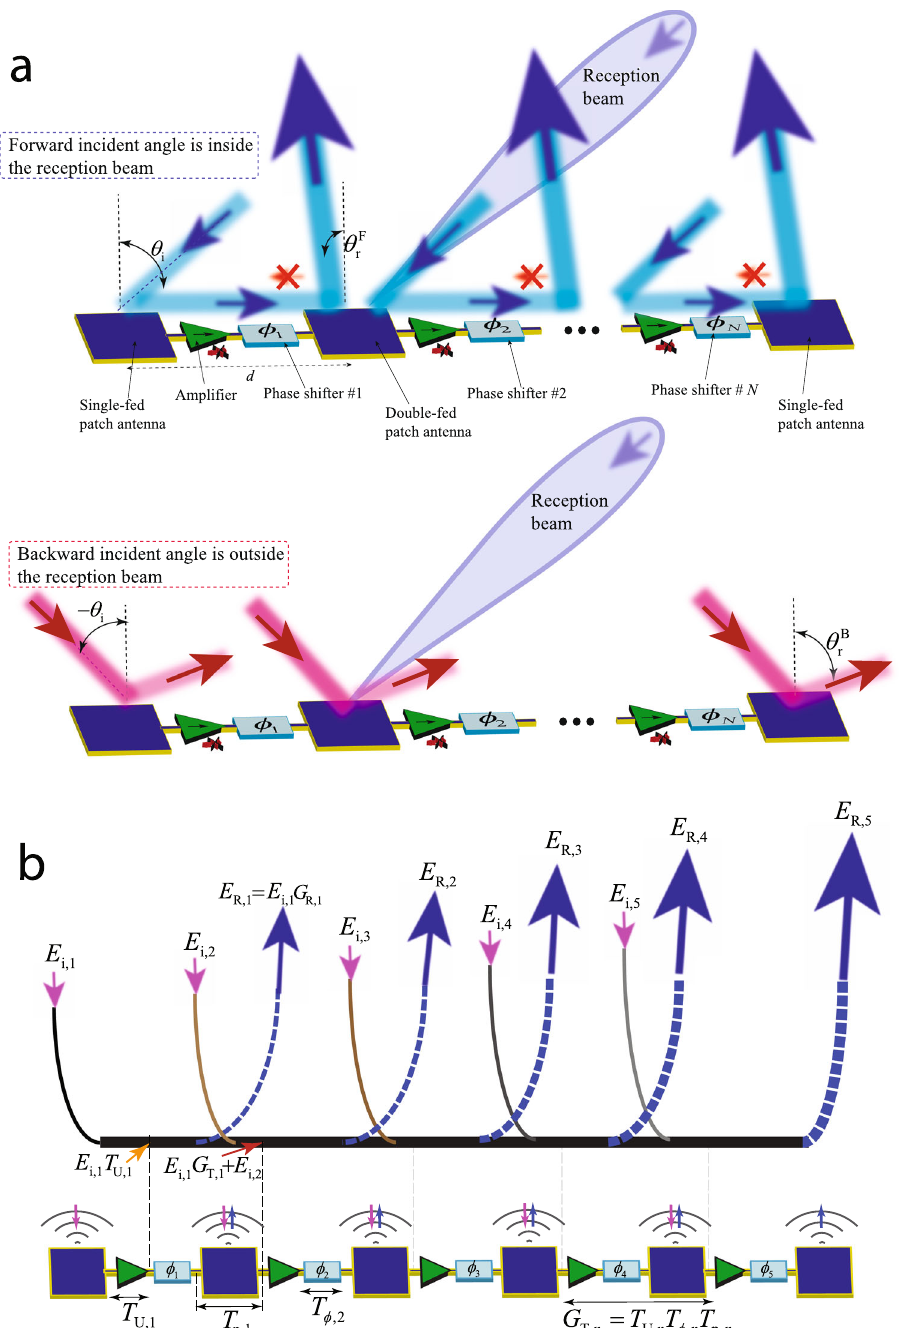
Fig. 4 Operation principle. a Nonreciprocity based on asymmetric reception beam. b Iterative wave incidence and re fl ection from the supercells of a chain and computation of the re fl ection angle and total gain using Eqs. (3) and (5),